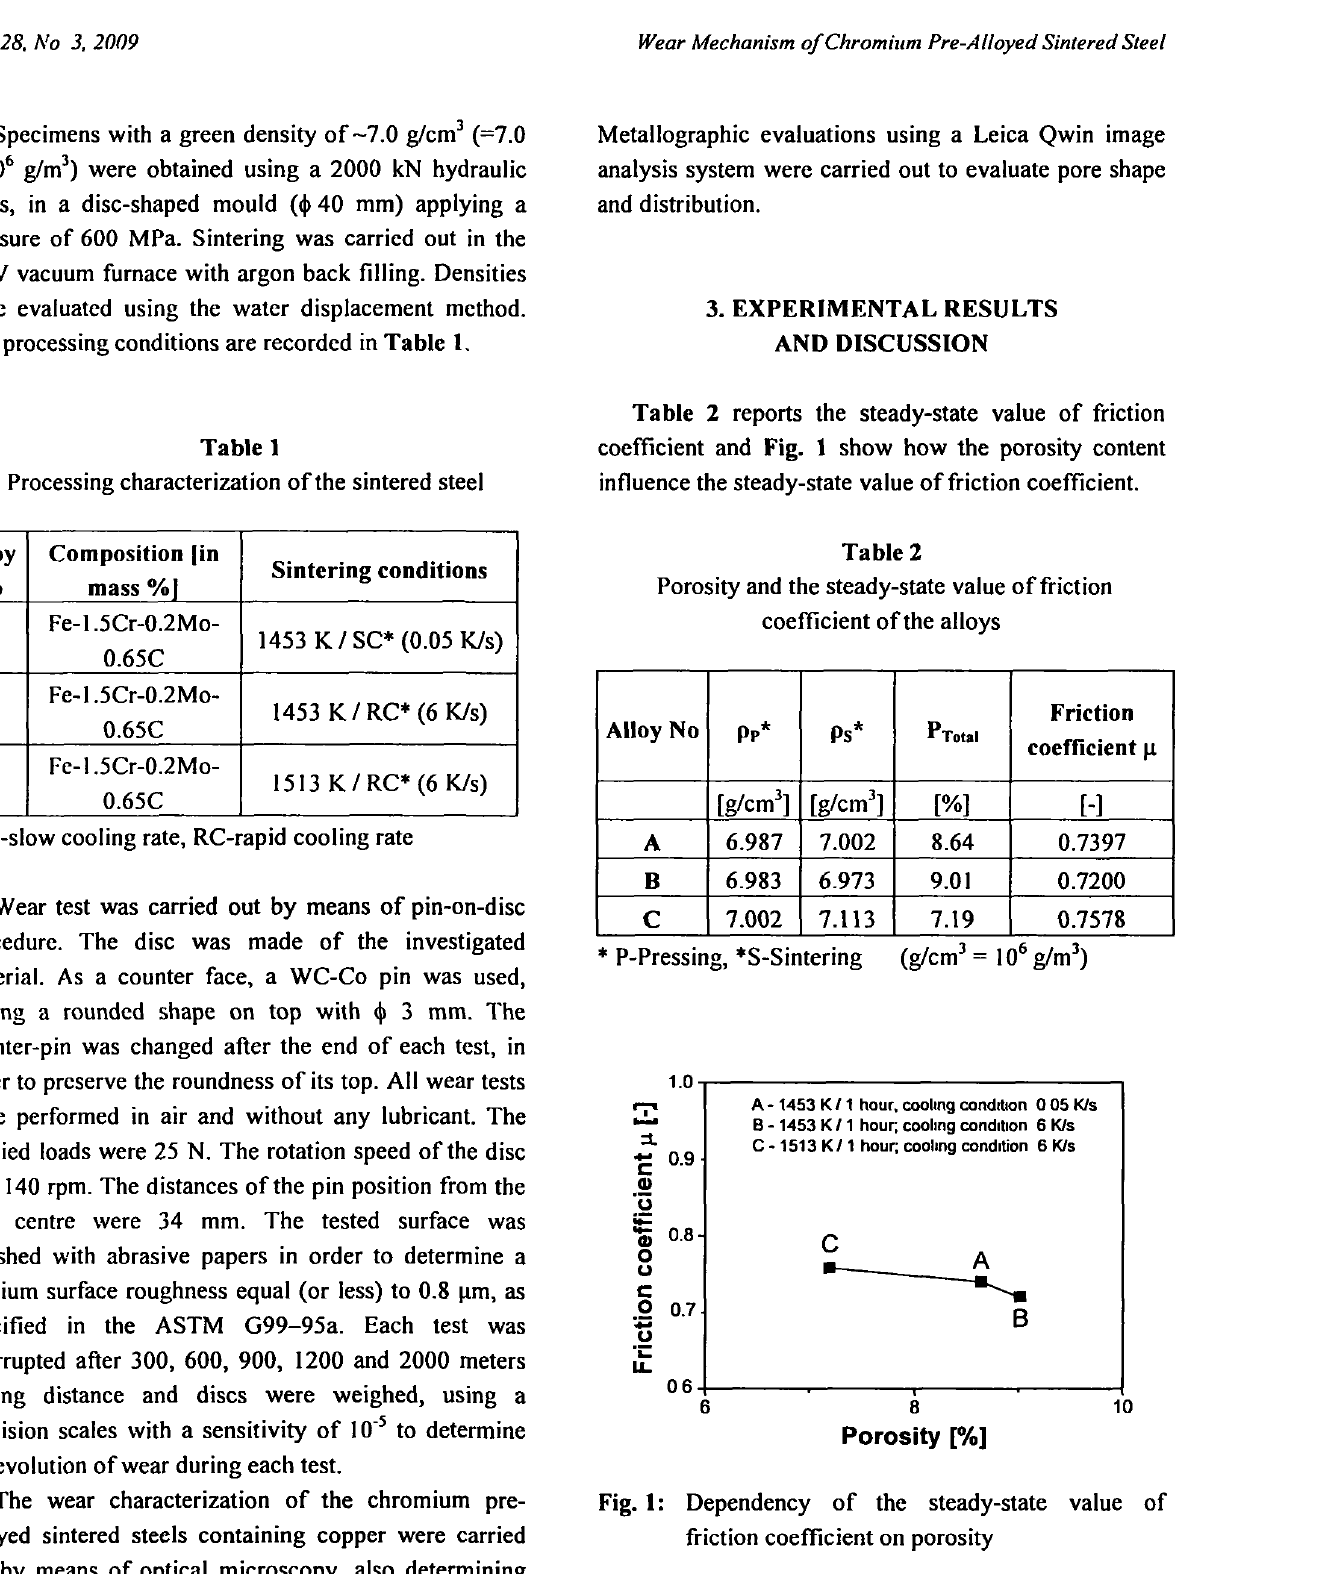
Porosity and the steady-state value of friction